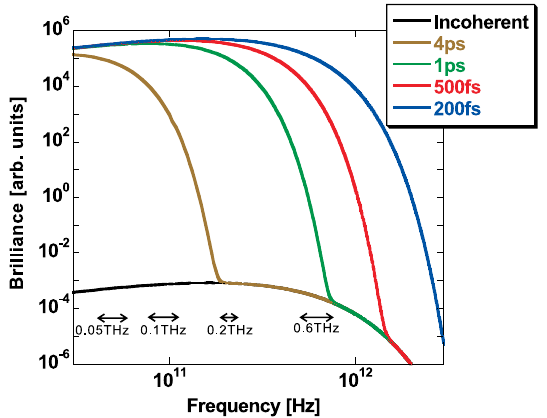
FIG. 13 (color online). Calculated synchrotron radiation spec- trum by a 3.7 MeV electron bent by a 0.14 T magnetic field. Coherent enhancement of various bunch lengths are plotted on the incoherent spectrum.